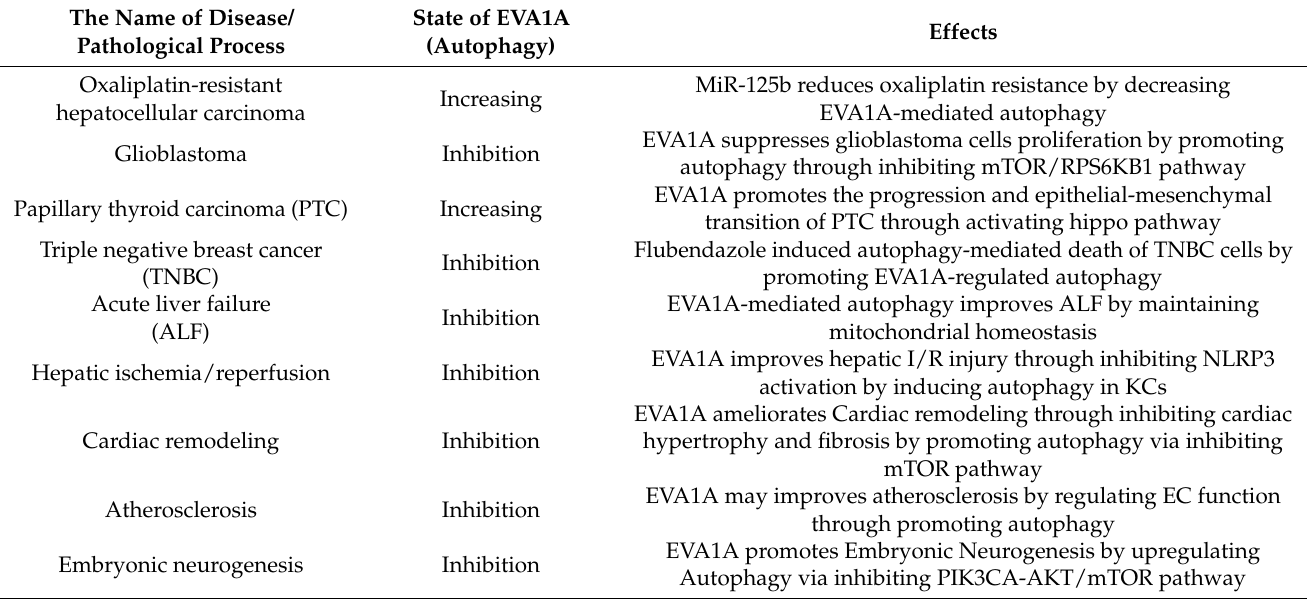
Table 1. The effects of EVA1A-mediated autophagy in different physiological and pathological processes. The Name of Disease/ Pathological